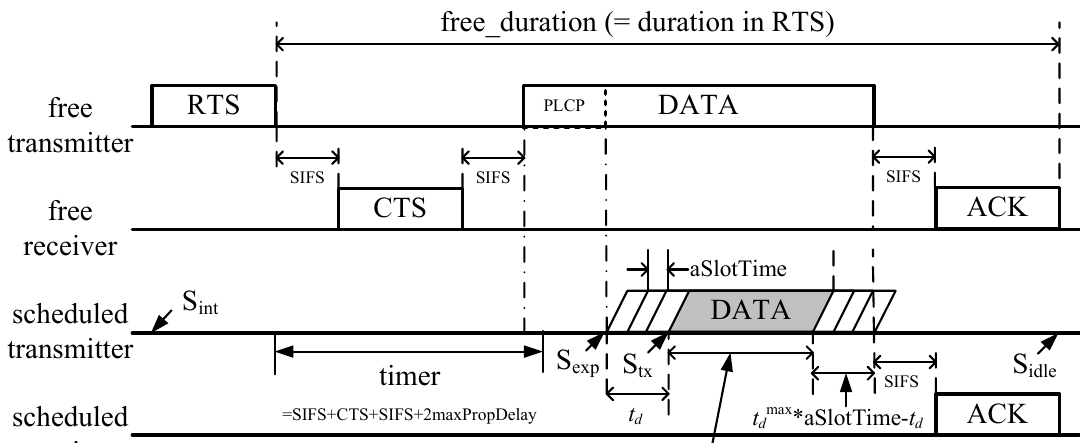
Figure 4. A time-line illustration of the proposed location-assisted MAC protocol.